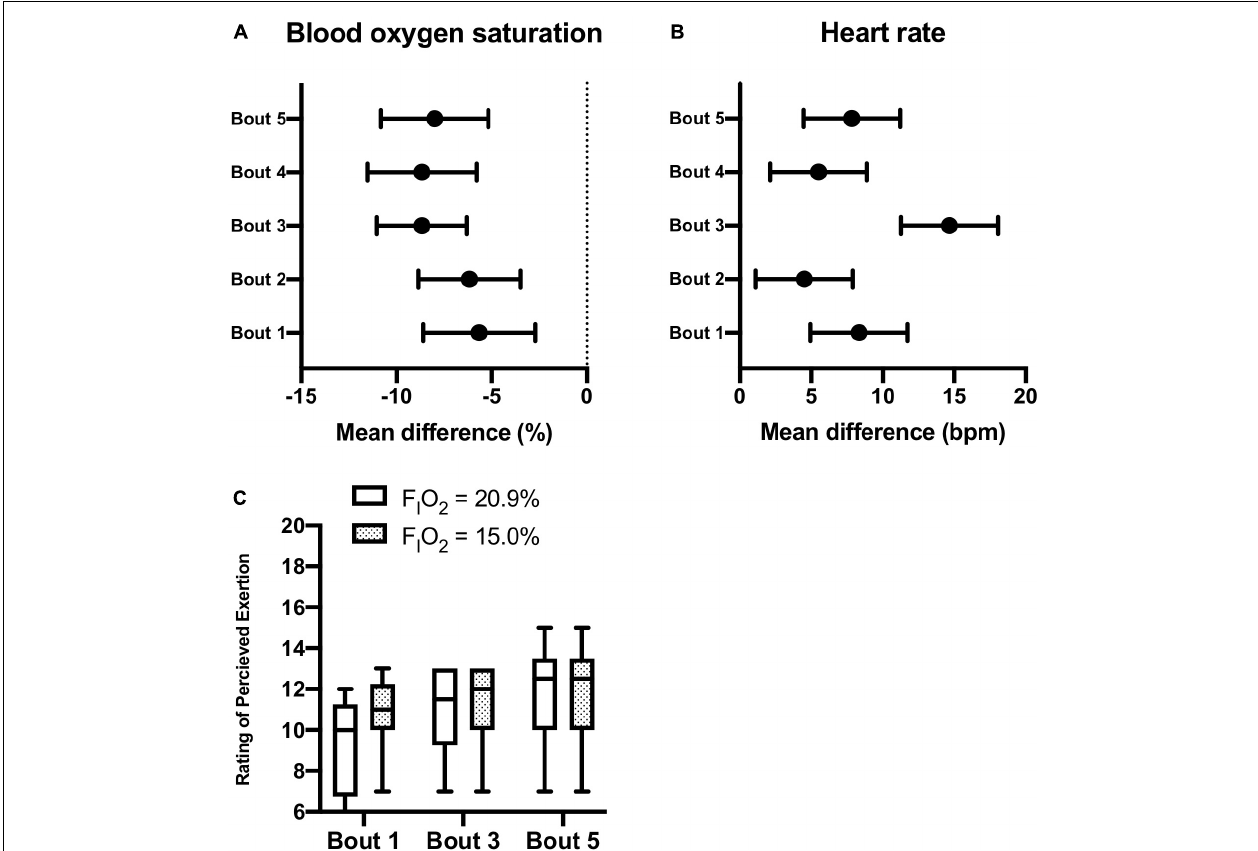
FIGURE 3 | Active Intermittent Normobaric Hypoxia Exposure. Effects of intermittent normobaric hypoxia exposure (F I O 2 = 15.0%) on blood oxygen saturation [panel (A) ], heart rate [panel (B) ], and rating of perceived exertion [panel (C) ] during constant workload exercise. Data reported as mean difference and 95% confidence interval for the difference between 2-min intervals of normoxia (F I O 2 = 20.9%) and normobaric hypoxia (F I O 2 = 20.9%). Each pair of normobaric hypoxia and normoxia intervals were defined as a bout (5-bouts in total). The box and whisker plots [panel (C) ] report the median along with the 25th and 75th percentiles and range (min to max) for rating of perceived exertion during constant workload exercise at the two levels of F I O 2 studied during bouts 1, 3, and